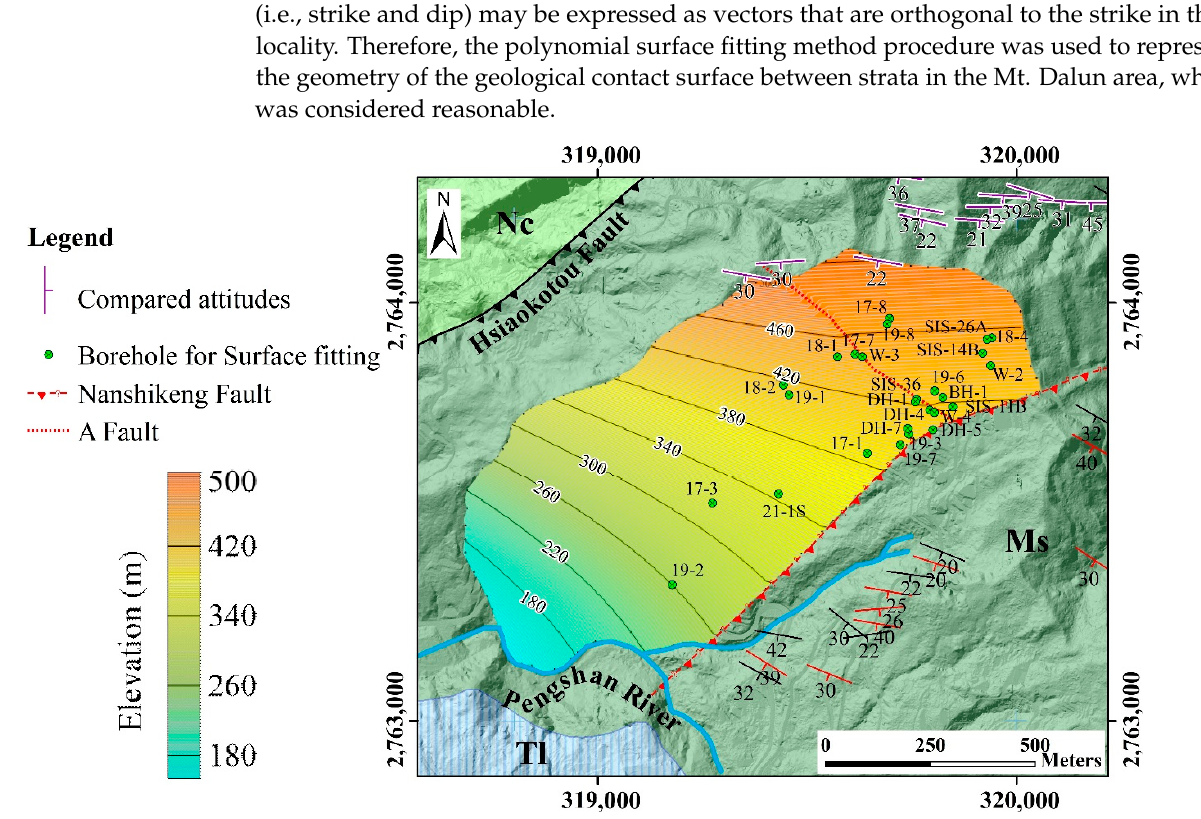
Figure 8. Structural contour of the top surface of the thick sandstone (L4, the key bed). By comparison with the outcrop measurements, a contour map with the contour interval of 2 m was created. The green circles indicate the locations of the boreholes used for the regression. The purple symbols of bedding attitudes can be utilized as a basis for comparison.